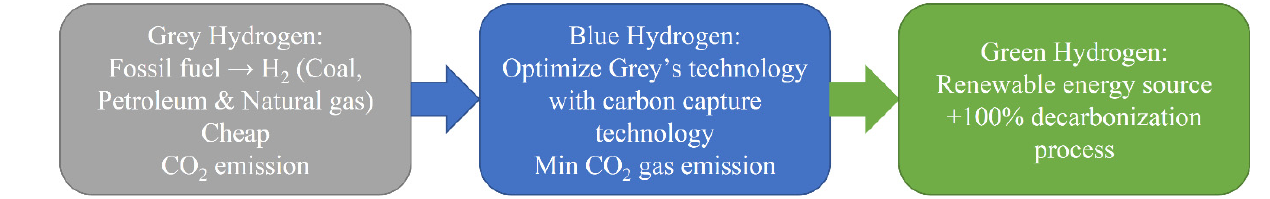
Figure 1. Three stages of hydrogen production.